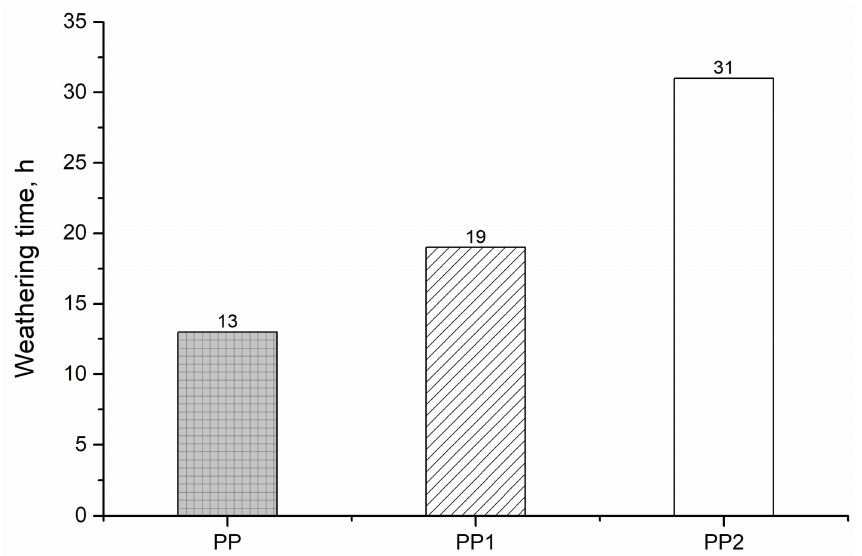
Figure 14. Time at which the elongation at break reaches one half of its initial value (hours) of the polypropylene and polypropylene